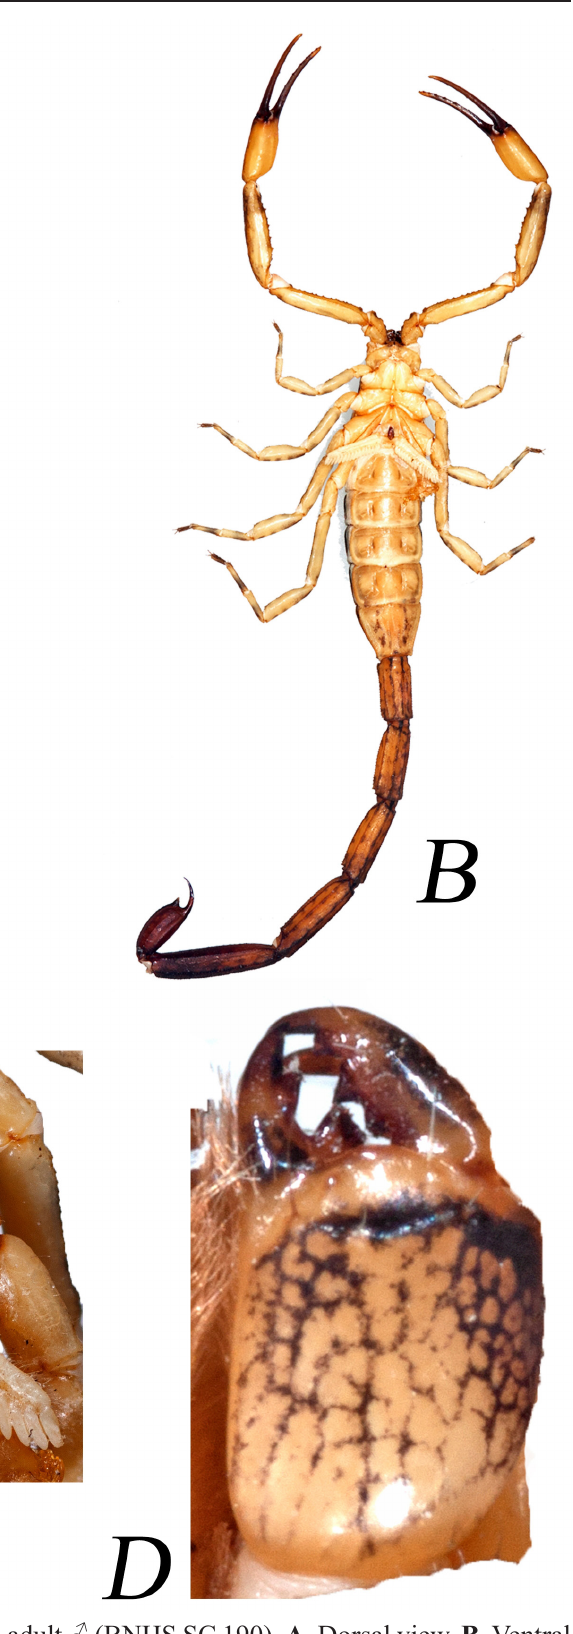
Fig. 13. Isometrus wayanadensis sp. nov., holotype, adult ♂ (BNHS SC 190). A . Dorsal view. B . Ventral view. C . Sternopectinal area. D . Chelicera, dorsal